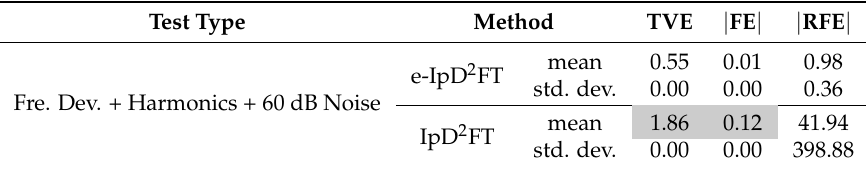
Table 9. TVEs (%), | FE | s (Hz) and | RFE | s (Hz/s) of the two methods. The Hanning window is